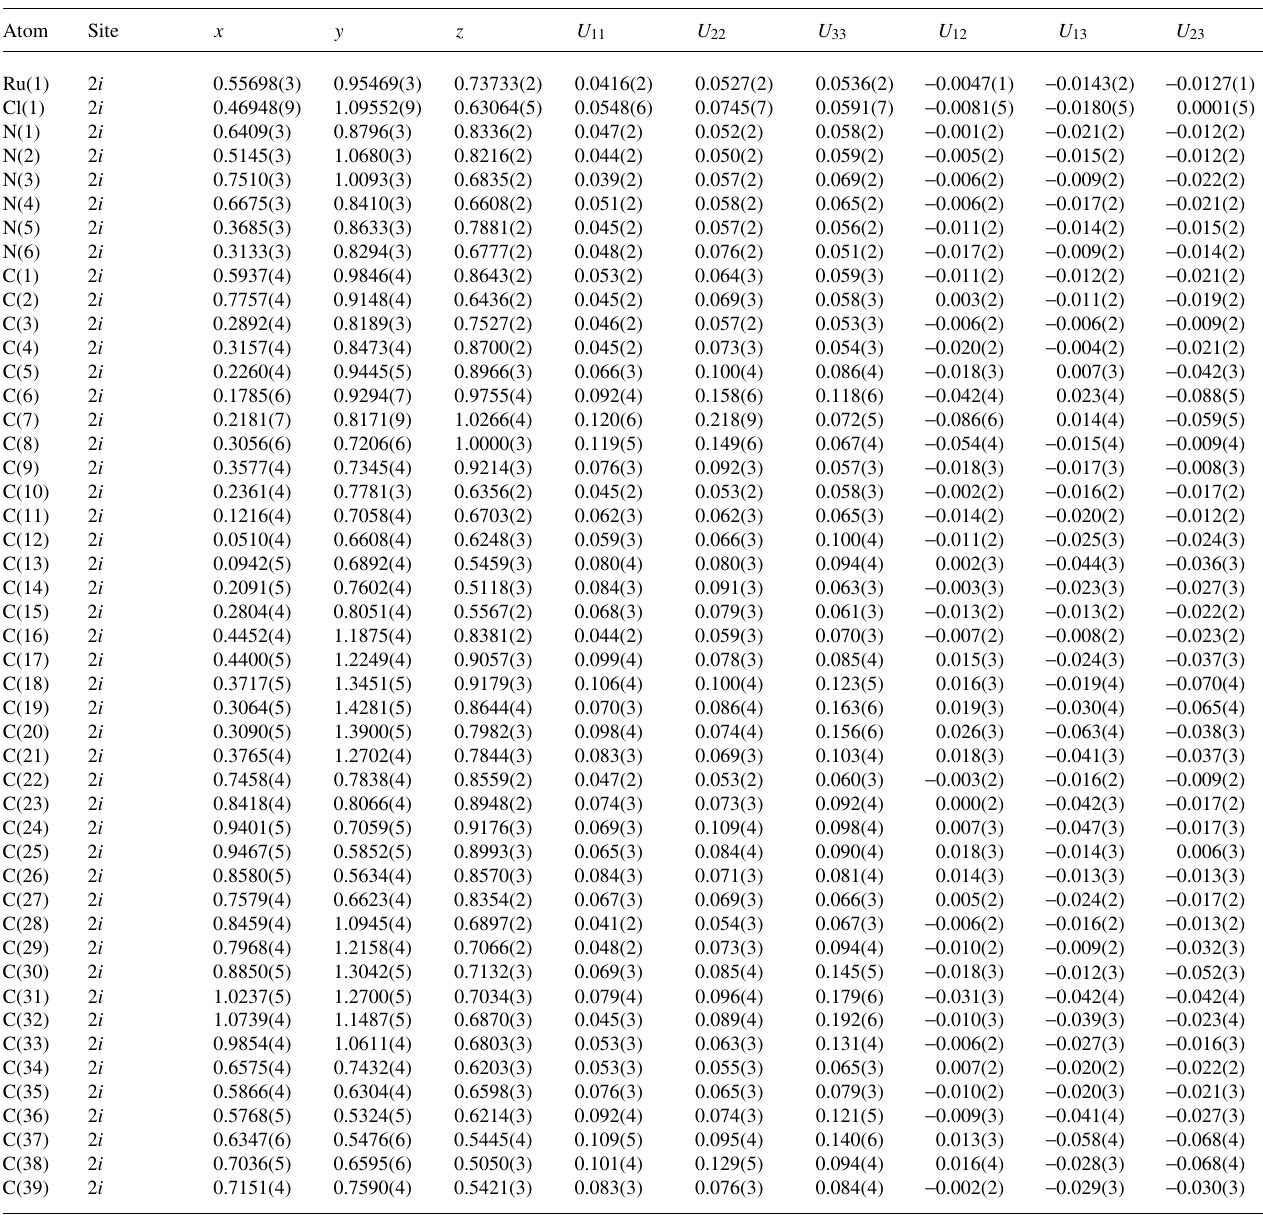
Table 3. Atomic coordinates and displacement parameters (in Å 2 )